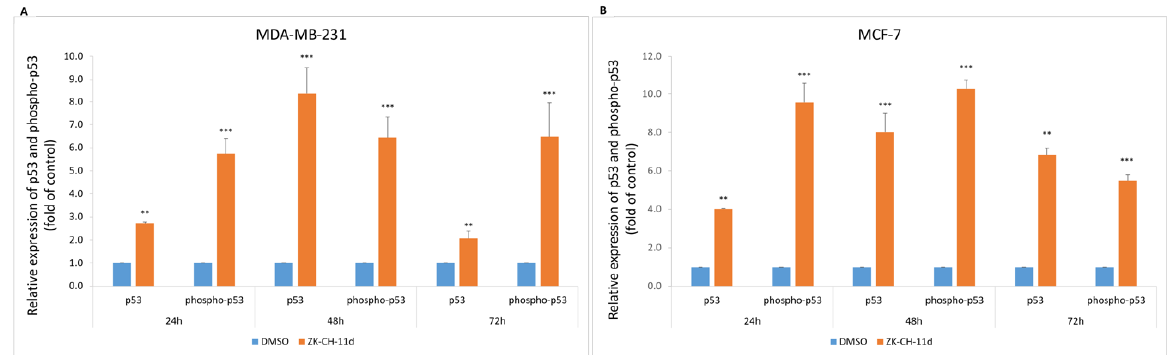
Figure 5. Flow cytometric analysis of p53 protein and its phosphorylated form in MDA-MB-231 ( A ) and MCF-7 ( B ) cells after 24, 48, and 72 h of ZK-CH-11d treatment at a concentration of 40 μmol/L. The values represent the mean of three independent experiments. Statistical significance: ** p < 0.01, *** p < 0.001 vs. DMSO (vehicle).